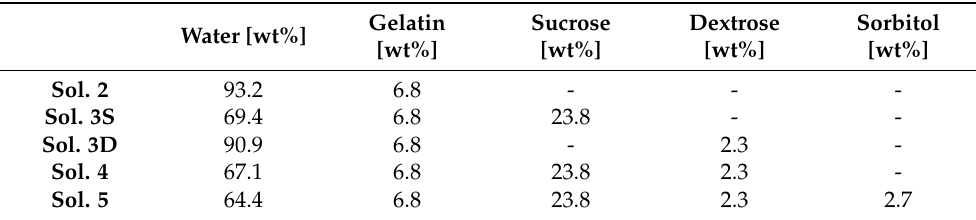
Table 1. Composition of multi-component gelatin solutions. Water [wt%]